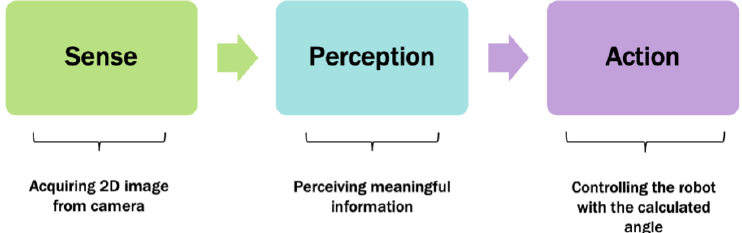
Figure 1. A block diagram of Sense-Perception-Action control architecture.